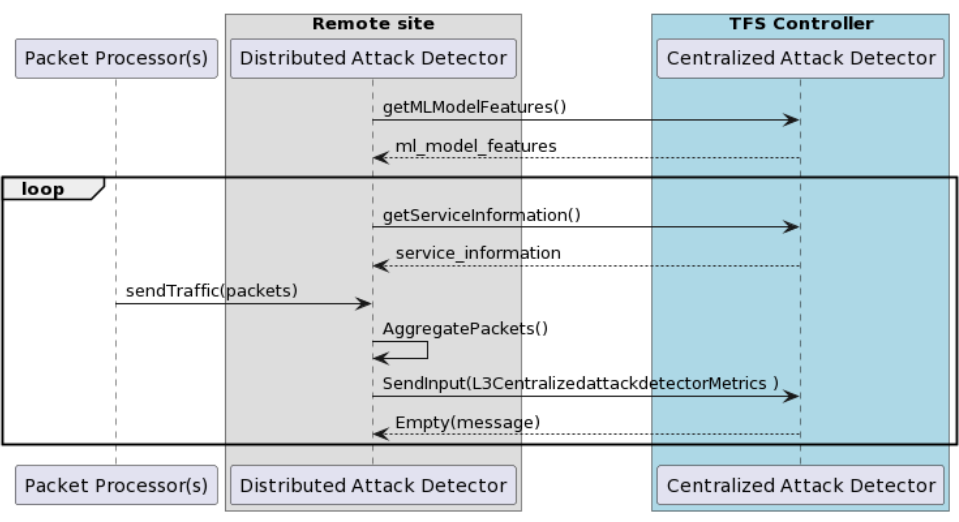
Figure 4. Distributed Attack Detector component